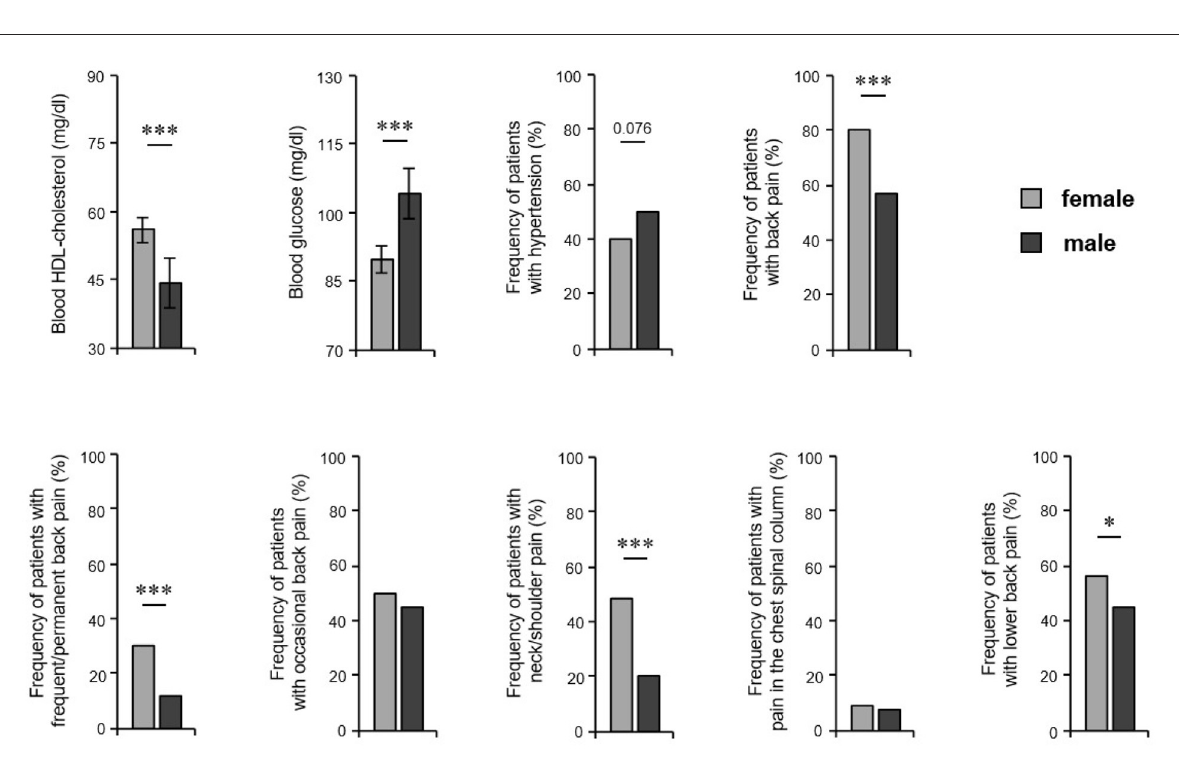
FIGURE4 HS comorbidity in both sexes. HS patients’ blood parameters including HDL-cholesterol ( n = 110, female: 52, male: 58) and glucose ( n = 122, female: 62, male: 60) are demonstrated as the mean ± SEM. The frequency of HS patients with arterial hypertension ( n = 355, female: 220, male: 135) and back pain (overall and broken down into different pain frequency and localizations) ( n = 474, female: 285, male: 189) are given. Significance of differences was assessed by the Mann–Whitney U-test (blood parameters) and the Chi-square test (pain frequency) (* P < 0.05, *** P ≤